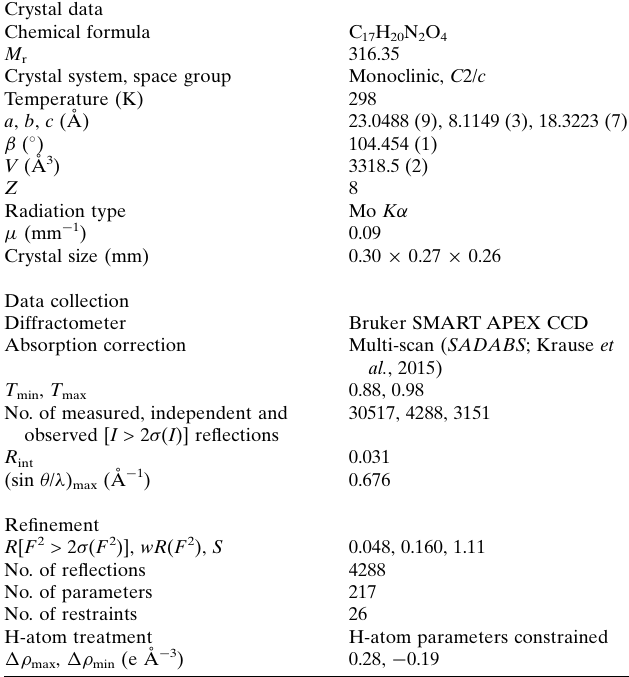
Table 1 Hydrogen-bond geometry (A˚ , (cid:2) ).